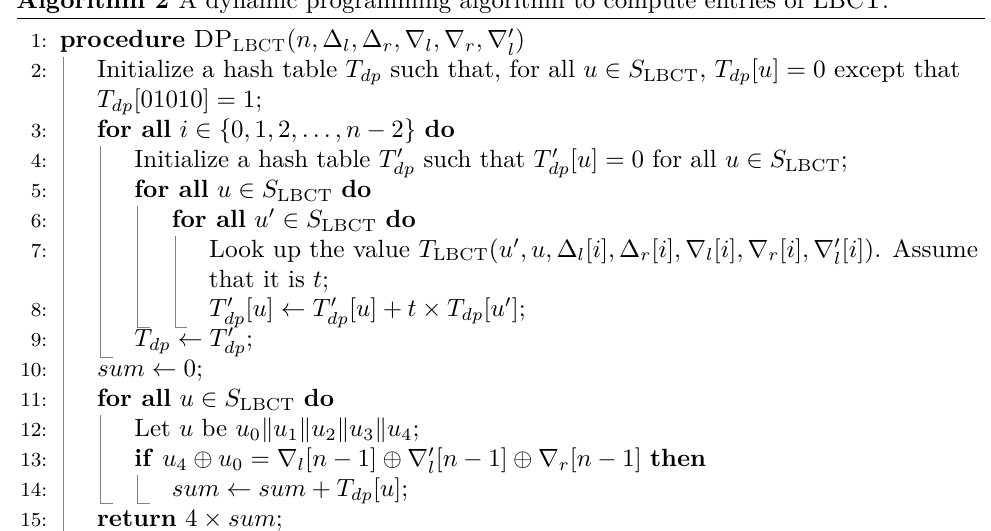
Algorithm 2 A dynamic programming algorithm to compute entries of